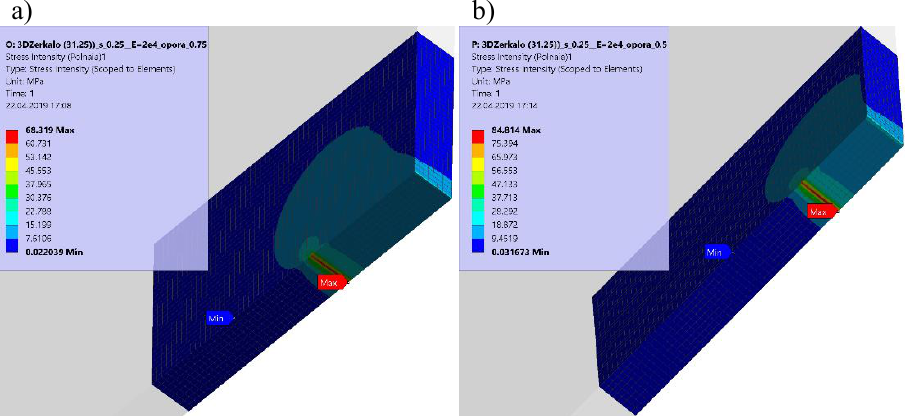
Fig. 14. Distribution of stress intensity σ i on the bottom surface of the deep beam for the following values: а) x 3 =3.25 m; б) x 3 = 3.50